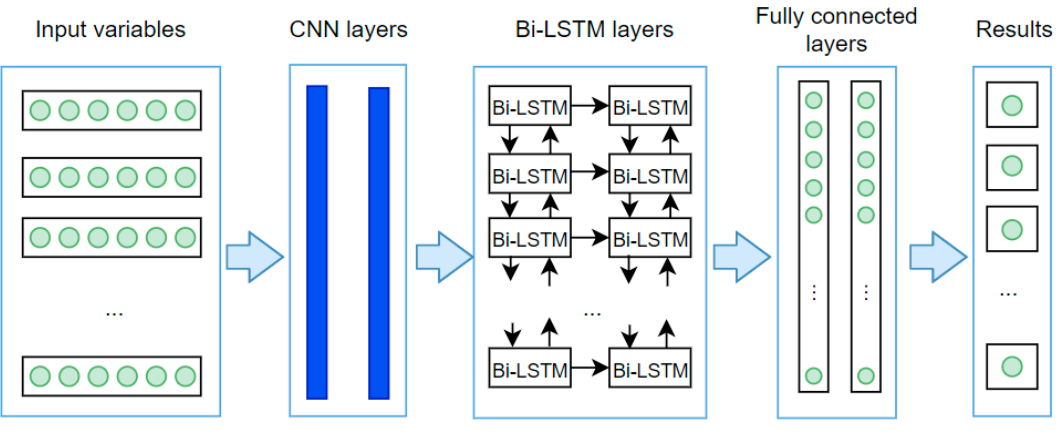
Figure 2. The overview architecture of EECP-CBL model.